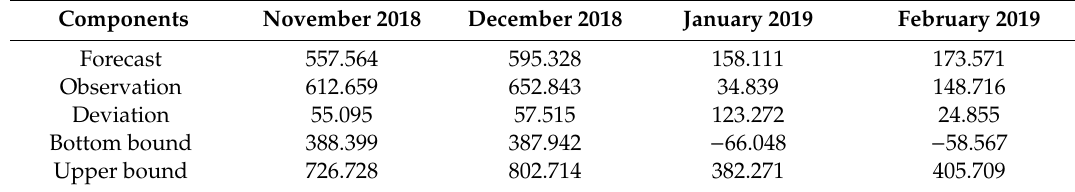
Table 8. Forecast profit of Bank C in IDR